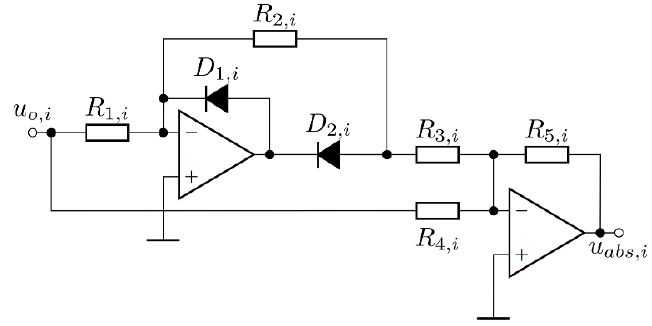
Figure 7. Measurement rectifier circuit.